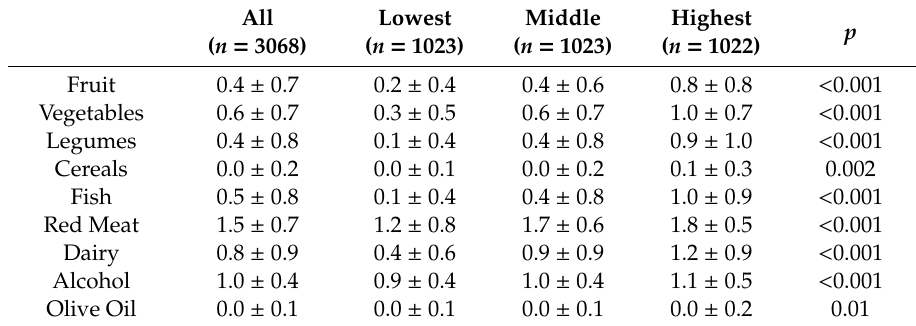
Table 3. Mean di ff erence in Mediterranean diet component scores by Mediterranean diet score category.